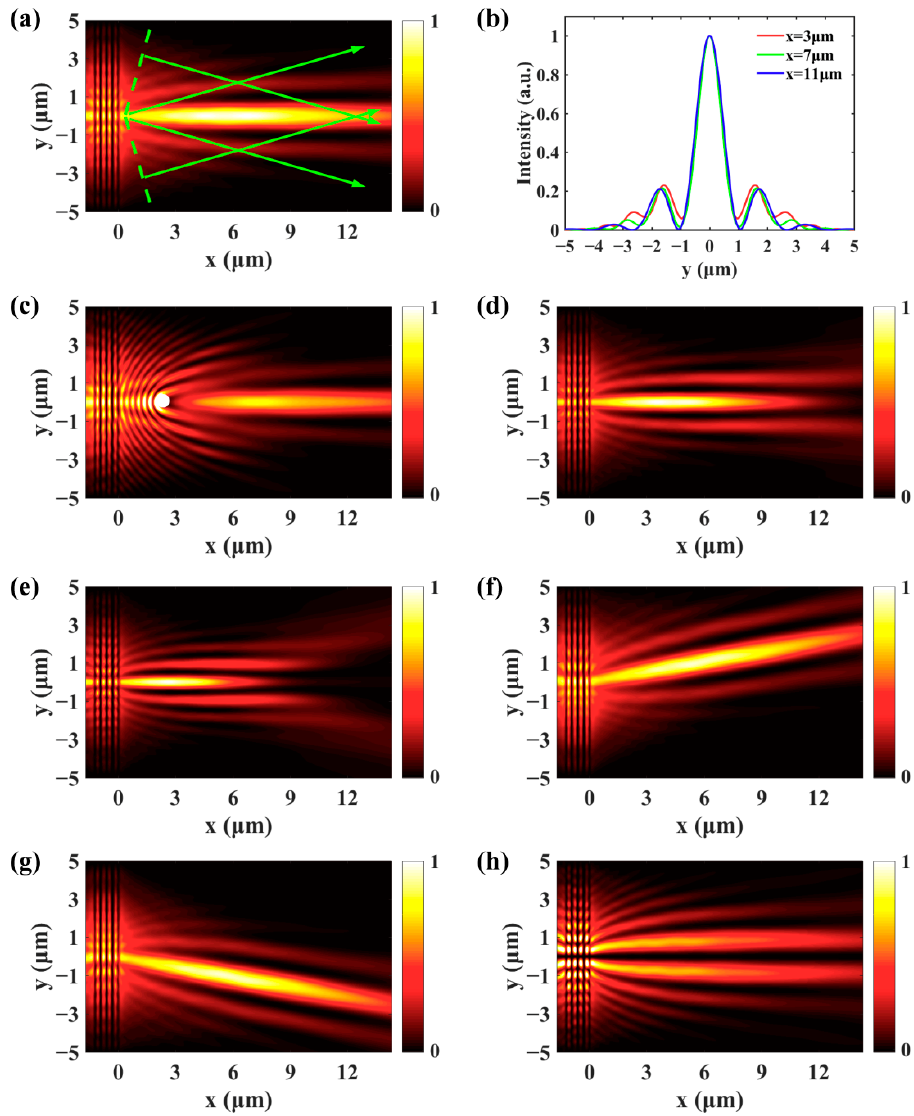
Figure 3. ( a ) The SPPs Bessel beam with the profile of zeroth-order Bessel function can be generated with a symmetrical phase β = 10 ◦ . ( b , c ) The nondiffracting and self-healing properties of the SPPs Bessel beam. By changing β , the FWHM of the main lobe and the length of the nondiffracting area can be modulated, β = 15 ◦ ( d ) and β = 20 ◦ ( e ). For α = 10 ◦ ( f ) and α = − 10 ◦ ( g ), the SPPs Bessel beam propagates upward and downward, respectively. ( h ) The SPPs beam takes on the profile of first-order Bessel function when the symmetrical phase is multiplied by a sign function.